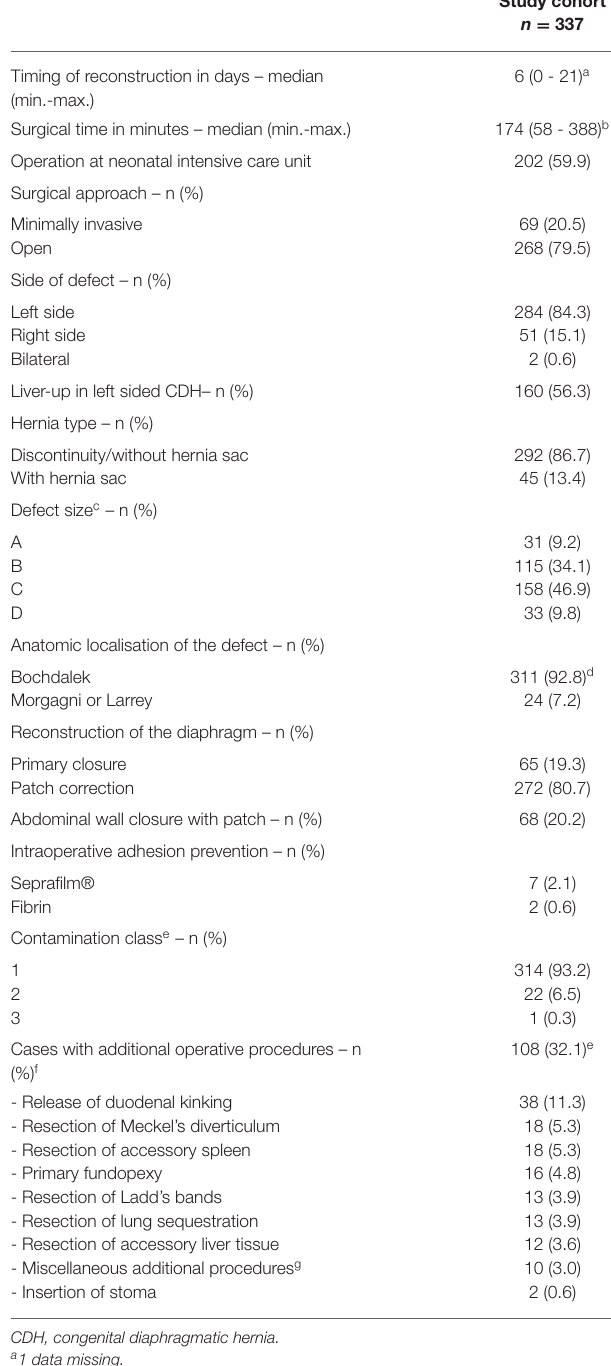
Study cohort n = 337